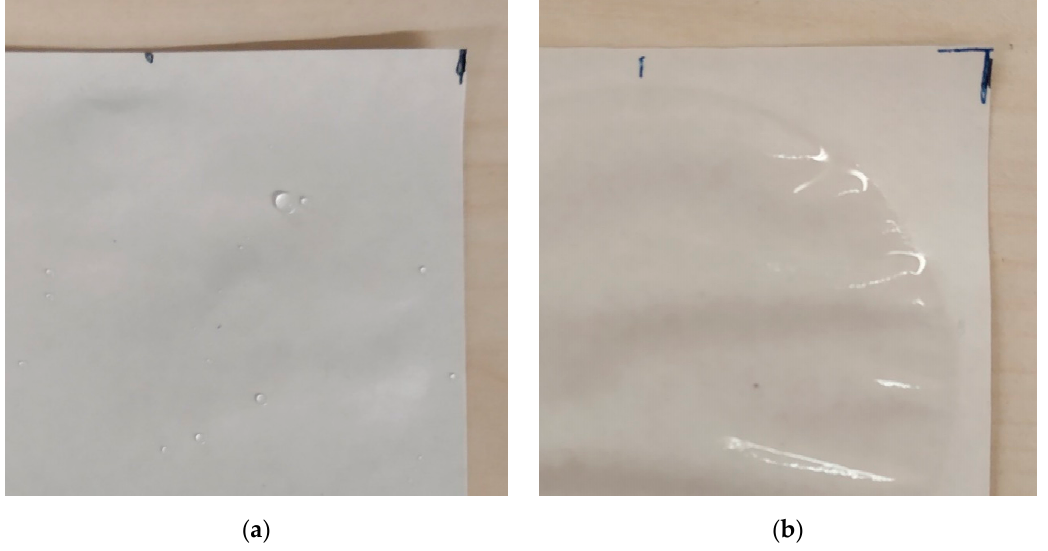
Figure 5. Different coating wettability. ( a ) SA-B over KB: water droplets are clearly visible; ( b ) H39K 80 over KB: water is evenly spread across the tested surface.